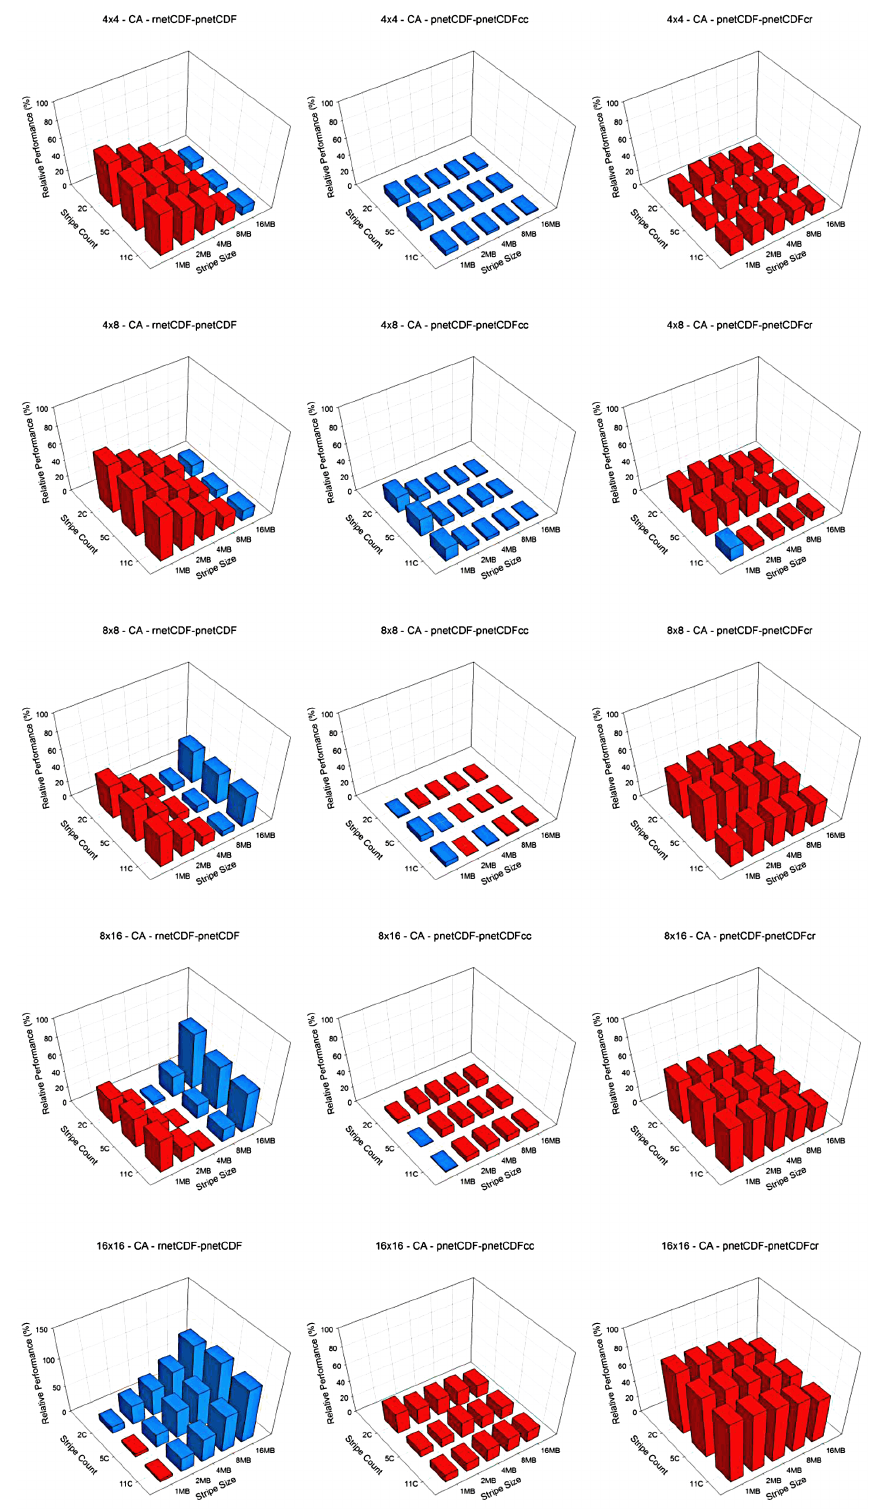
Figure 4. Relative I/O performance of pnetCDF to rnetCDF, and pnetCDFcc and pnetCDFcr to pnetCDF on the CA domain with 4 × 4, 4 × 8, 8 × 8, 8 × 16, and 16 × 16 processor configurations from Edison. Red color denotes positive value in relative performance while blue color denotes negative value in relative